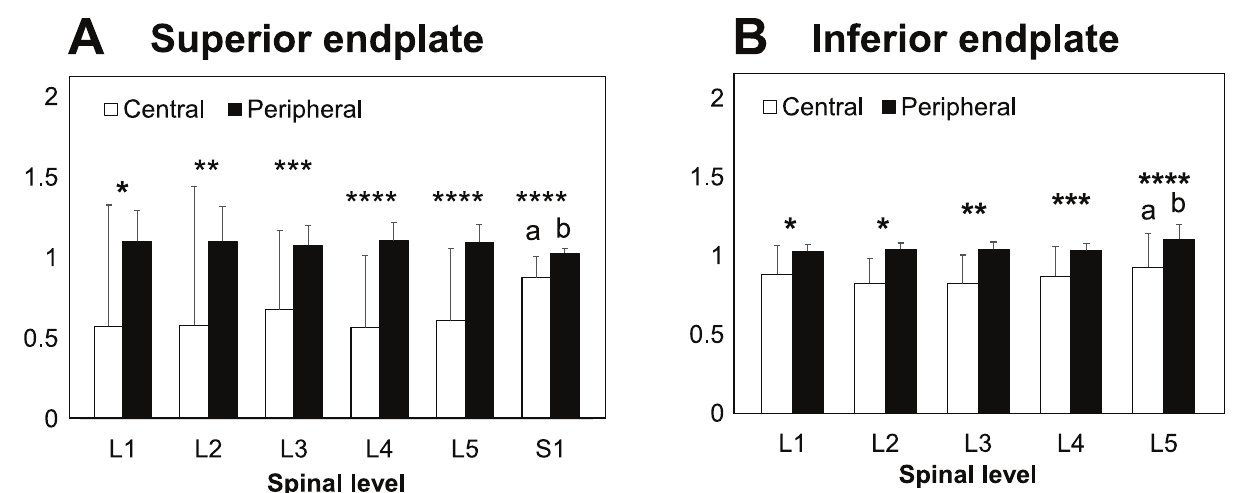
Fig 6. A. Comparison of the BMD in the central and peripheral zones of the superior endplate among different spinal levels and within the superior endplate. a: p < 0.009 compared with central region of the superior endplates at L4. p < 0.05 compared with central region of the superior endplates at L5. b: p < 0.009 compared with peripheral region of the superior endplates at L4. p < 0.05 compared with peripheral region of the superior endplates at L5. � : p < 0.007 between central vs. peripheral regions in the same spinal level. �� : p < 0.02 between central vs. peripheral regions in the same spinal level. ��� : p < 0.002 between central vs. peripheral regions in the same spinal level. ���� : p < 0.0001 between central vs. peripheral regions in the same spinal level. B. Comparison of the BMD in the central and peripheral zones of the inferior endplate among different spinal levels and within the inferior endplate. a: p < 0.03 compared with central region at L3. b: compared with peripheral region at L1 (p < 0.02), L2 (p < 0.05) and L4 (p < 0.003). � : p < 0.003 between central vs. peripheral regions in the same spinal level. �� : p < 0.0001 between central vs. peripheral regions in the same spinal level. ��� : p < 0.002 between central vs. peripheral regions in the same spinal level. ���� : p < 0.0007 between central vs. peripheral regions in the same spinal level.